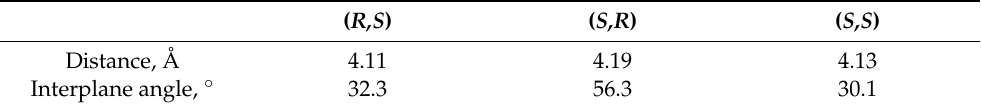
Table 5. Average distances and interplane angles in three optical configurations of KP-Trp dyad obtained from Hyperchem models (see Supplementary Figures